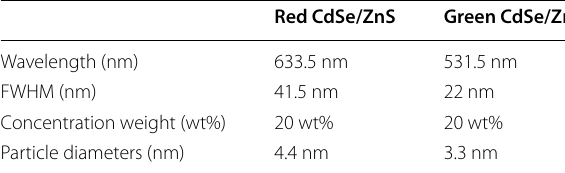
Table 1 Specifications of red and green CdSe/ZnS samples